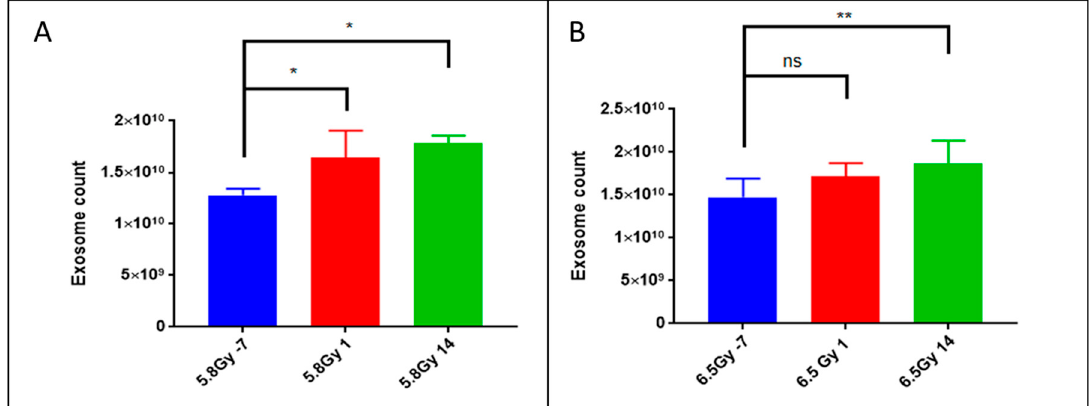
Figure 1. 5.8 Gy and 6.5 Gy irradiation exposure results in significantly increased exosomal shedding. Using quantitative ELISA targeting CD63, a well-known marker for exosomes, plasma-derived exosome samples were quantified. After exposure to 60 Co γ -radiation, an increase in the number of isolated exosomes was noted. Exosome counts at 7-d prior, 1 d post- and 14 d post-irradiation